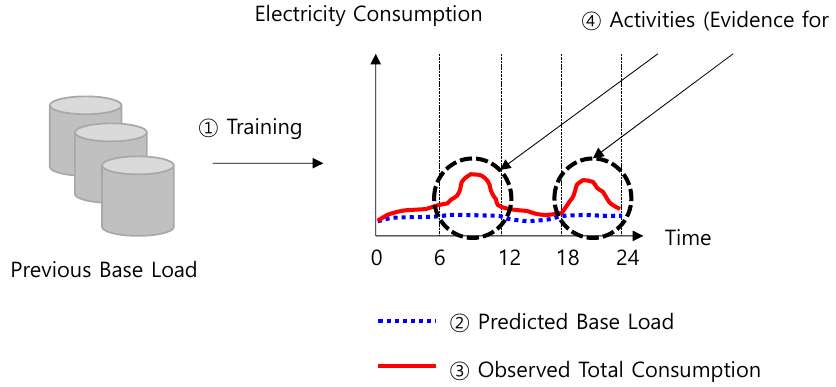
Figure 3. Proposed activity detection-based analysis method.